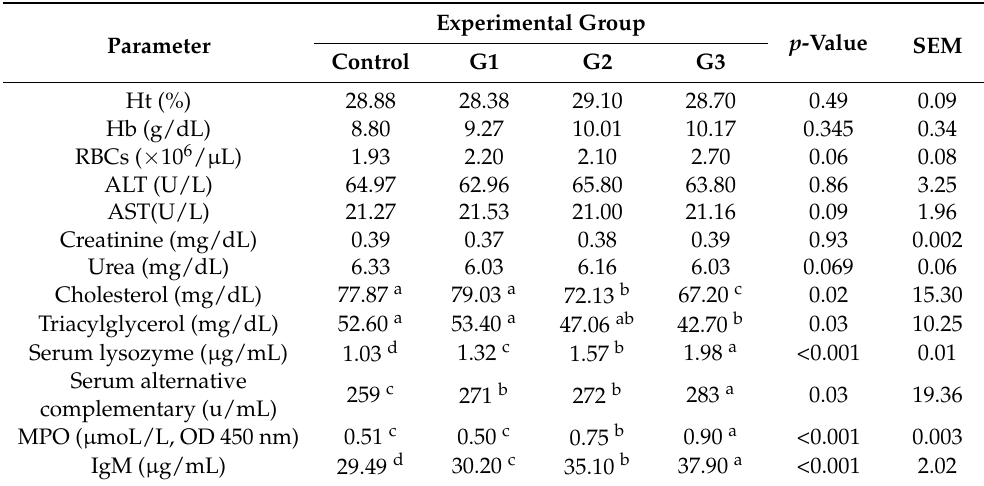
Table 4. Hematological, biochemical and immunological markers of Nile tilapia ( O. niloticus ) fed diets fortified with Thy and/or ThQ for 12